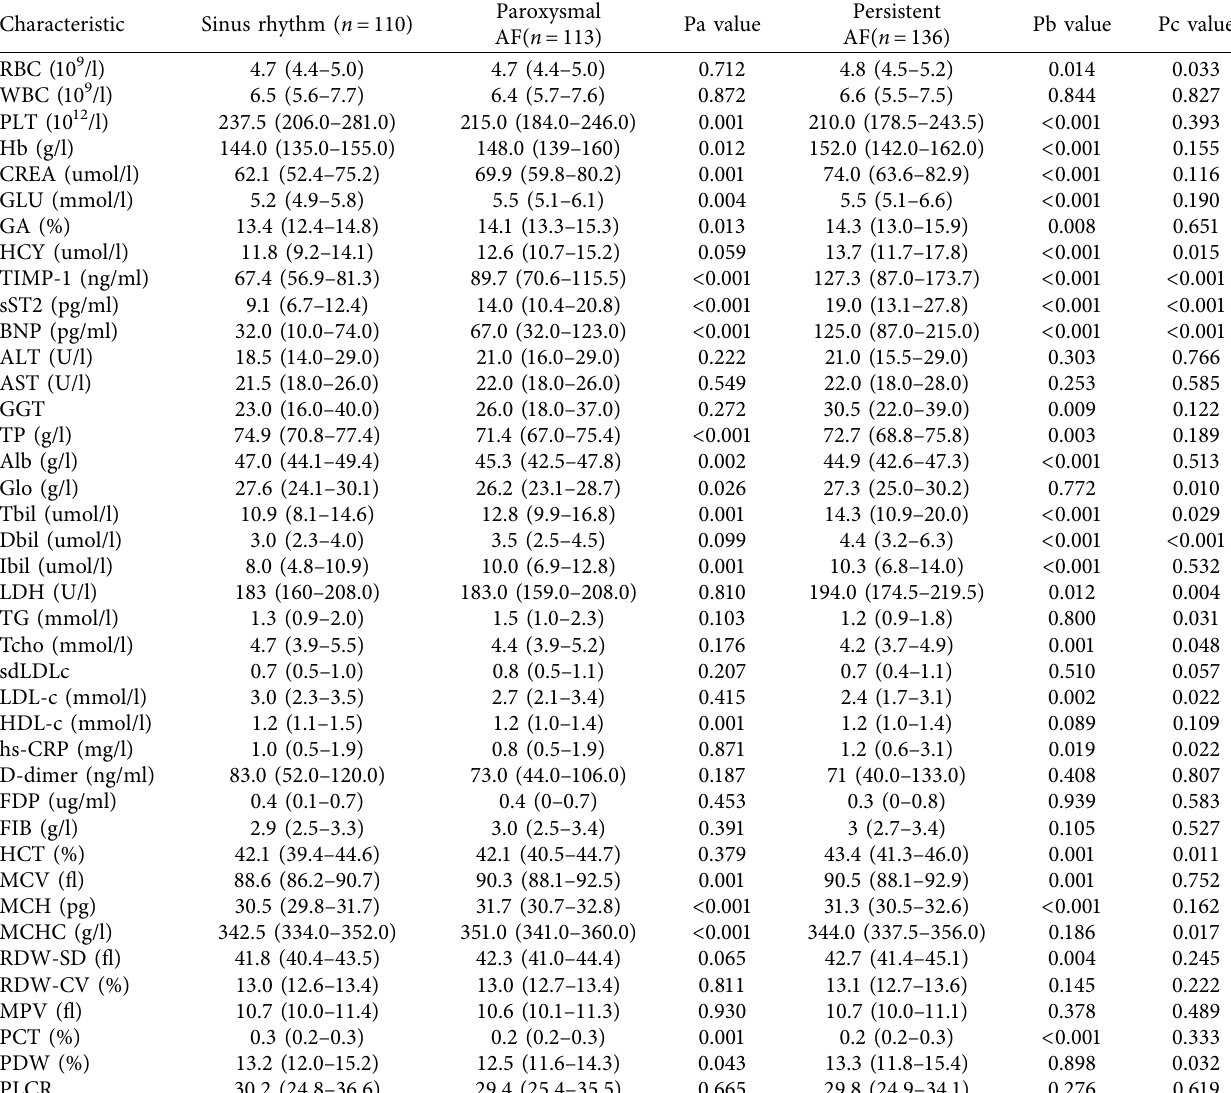
Table 2: Laboratory examination of participants stratifed according to AF